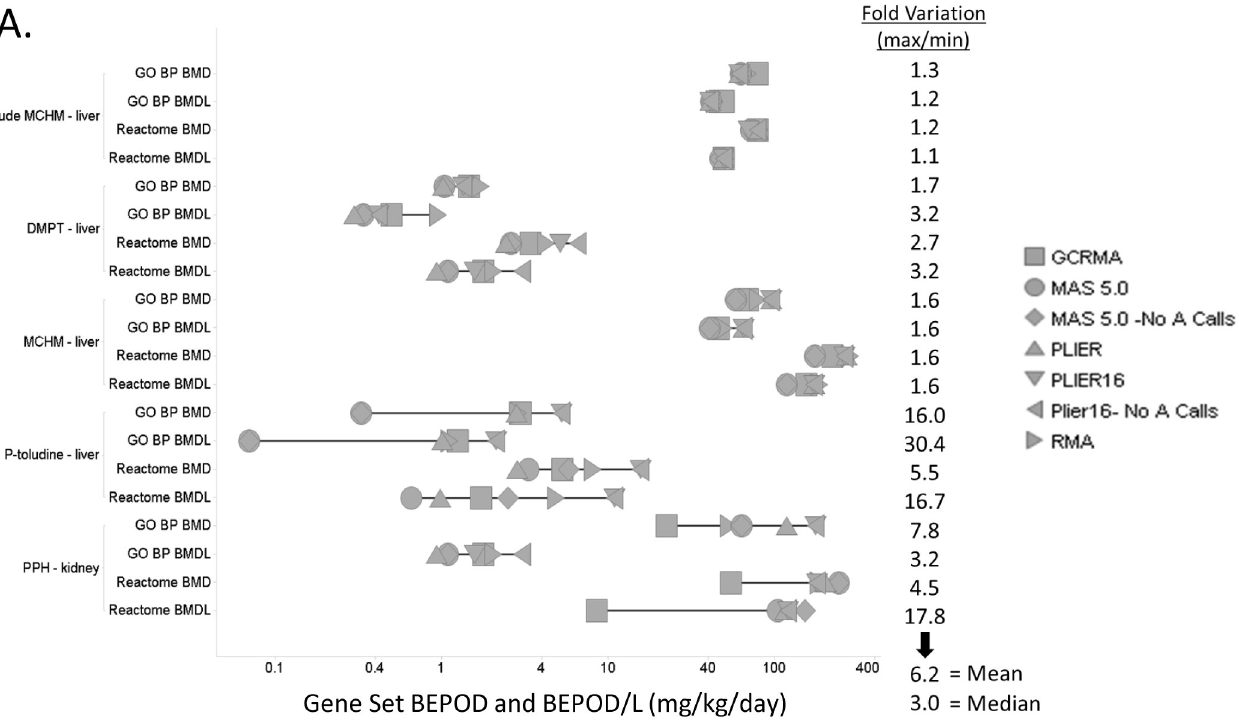
Fig 4. Effect of normalization on the lowest median BMD (BEPOD) and BMDL (BEPOD/L) values for GO:BP and Reactome pathways. The distribution of BEPOD and BEPOD/L values across 7 normalizations are shown for each of the 5 experiments. Fold variation: max BEPOD to min BEPOD (or max BEPOD/L to min BEPOD/L) ratio. Mean and median fold variations are shown for BEPOD/L vales.